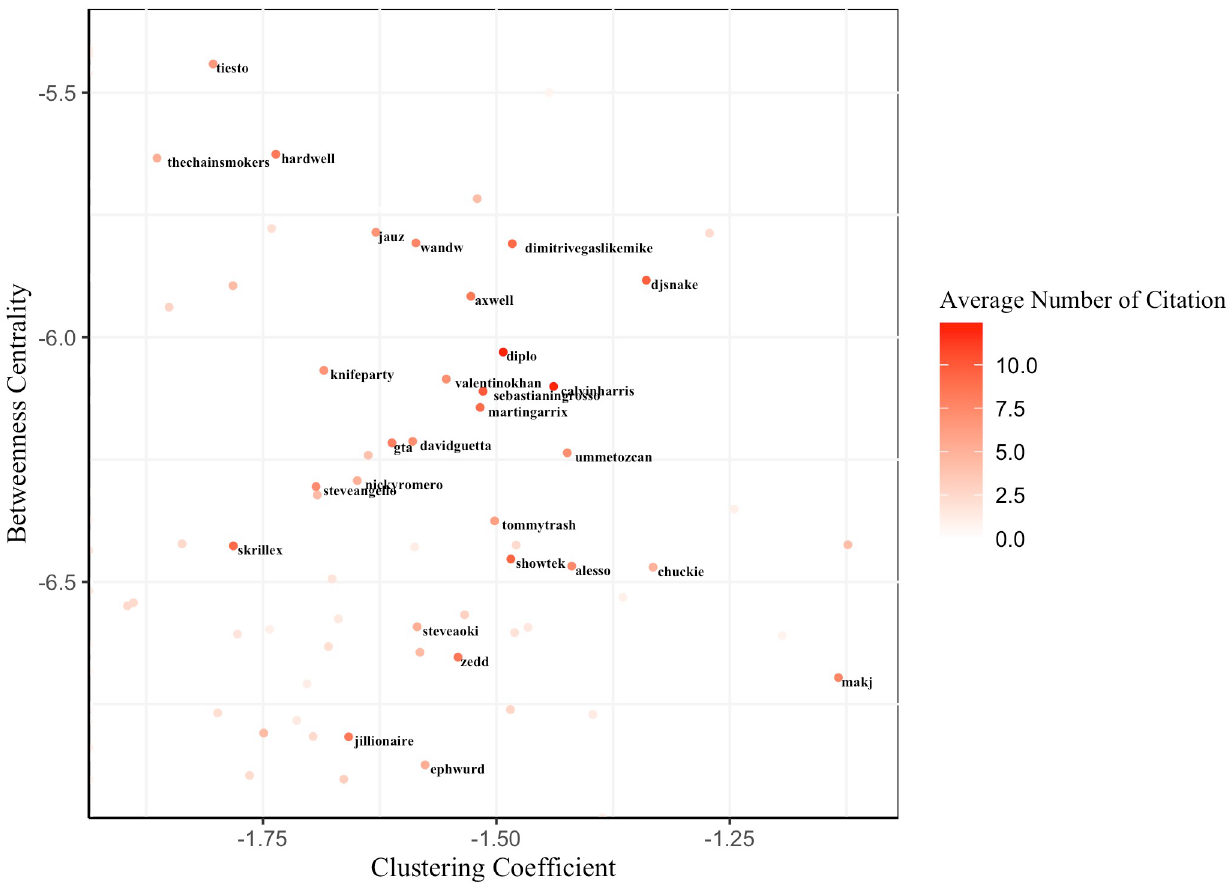
Fig 3. Hybrid social positions of 30 most cited DJs. This figure is a magnified cut-out of the upper right quadrant of Fig 2. The name-tagged DJs are well- known representatives of each musical